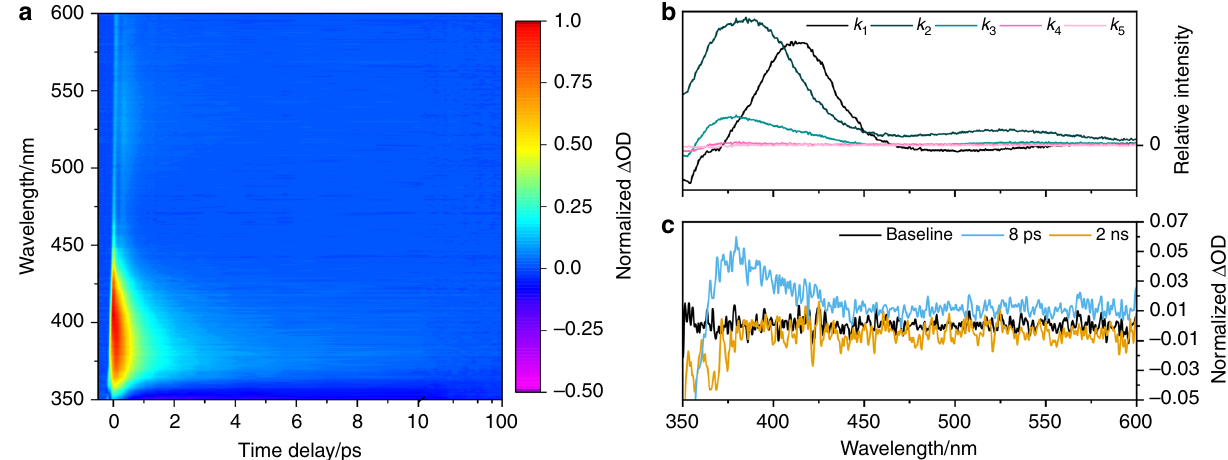
Fig. 2 Ultrafast spectroscopy results for DES. a Transient absorption spectrum (TAS) of DES in C12 – 15 alkyl benzoate deposited on a synthetic skin mimic, VITRO-CORNEUM ® (VC/AB) photoexcited at 335 nm, shown as a false colour map, with the intensity scale representing a change in normalized optical density ( Δ OD). The time-delay is plotted linearly from − 0.5 to 10 ps then as a log scale from 10 to 100 ps. b Evolution associated difference spectra (EADS) from the sequential global fi t of the TAS of DES in VC/AB photoexcited at 335 nm. Zoomed-in plots showing only k 4 and k 5 for this system can be found in Supplementary Fig. 6a). c Selected TAS at speci fi c Δ t highlighting the absorption at 380 nm (8 ps, green) and incomplete ground state